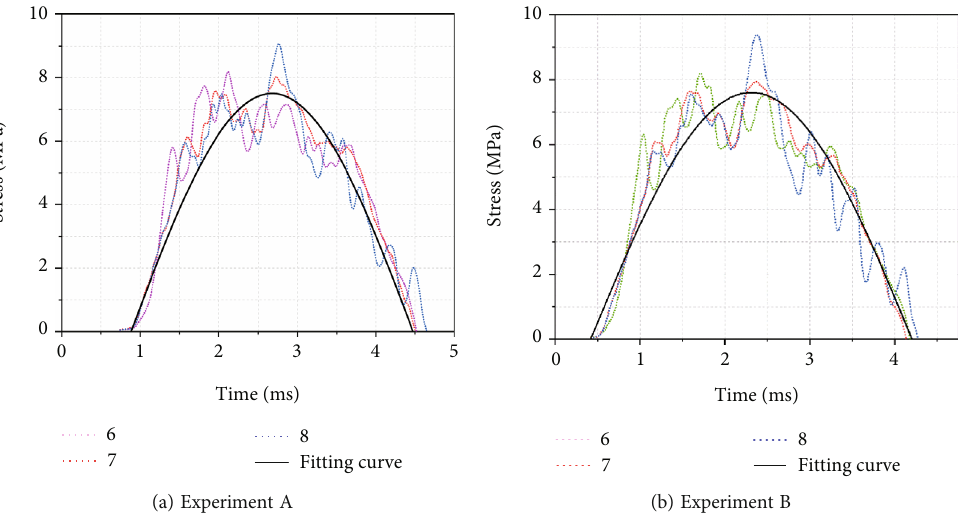
Figure 17: Stress curves of group II.